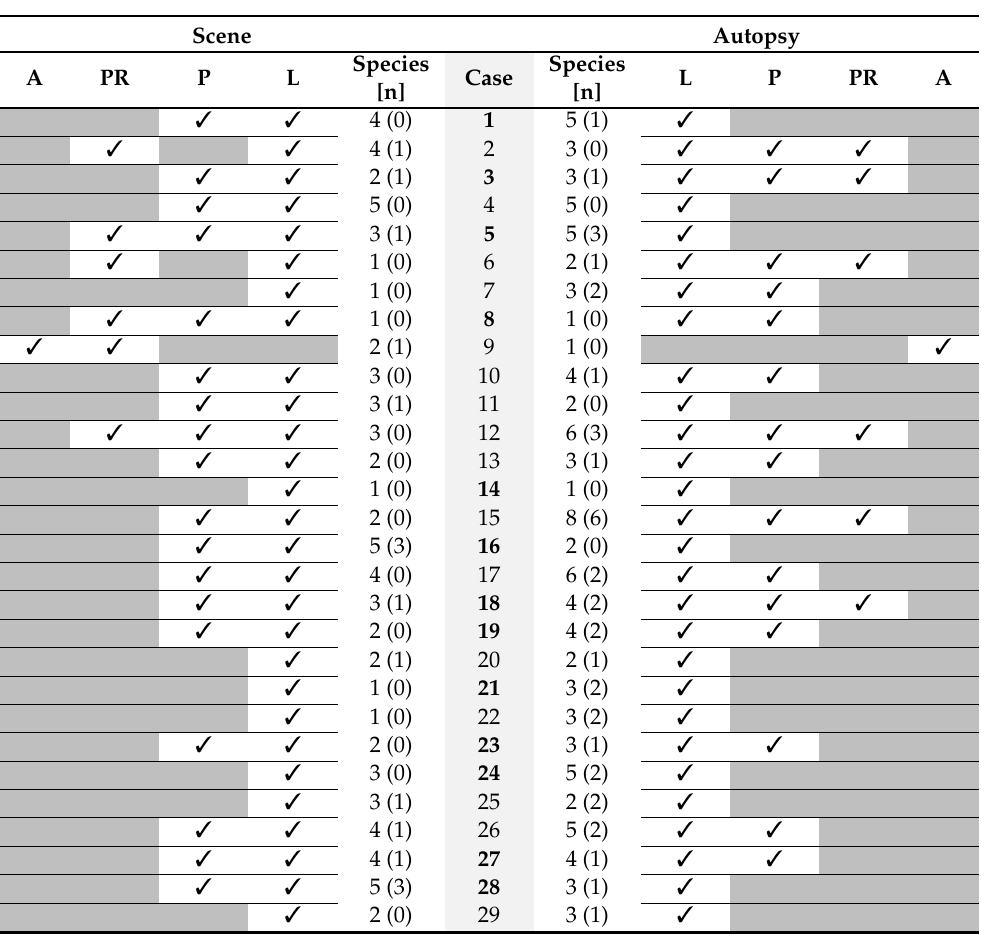
Table 3. Summary of cases where entomological samples were taken at the scene and during autopsy from November 2018 to October 2020. Information on the number of insect species is given. In brackets species unique to the scene or autopsy are listed. The stages of development found, where A= adult specimen, PR = puparia, P = pupae, L = larvae, are listed. In bold are all cases where the larval length was measured. The check mark indicates if a developmental stage was found and the dark gray filling if it was